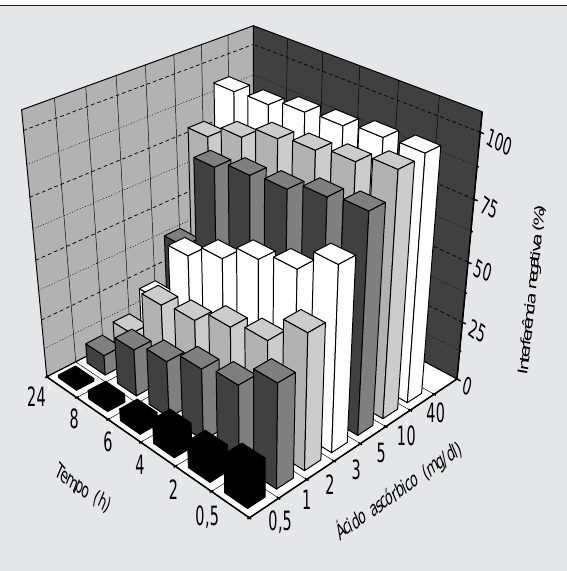
Figura 4 – Interferência negativa do ácido ascórbico na determinação de ácido úrico. Ácido ascórbico (concentração final) foi adicionado ao pool de soro e as determina- ções foram realizadas após diferentes períodos de tempo. As amostras permaneceram à temperatura ambiente. Os resultados são médias de duas ou três determinações para cada variável realizada com os diferentes reagentes estudados, os quais utilizam o sistema